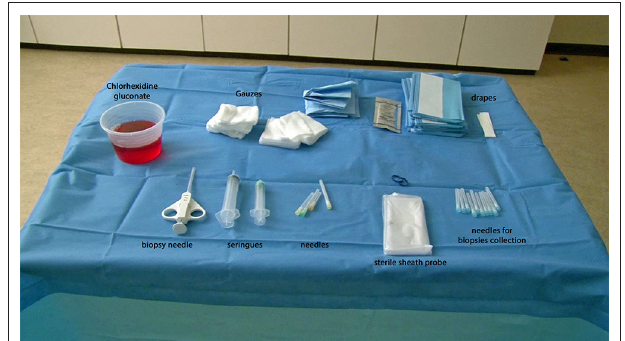
FIGURE 1 | Prepared table with the material needed for ultrasound-guided synovial needle